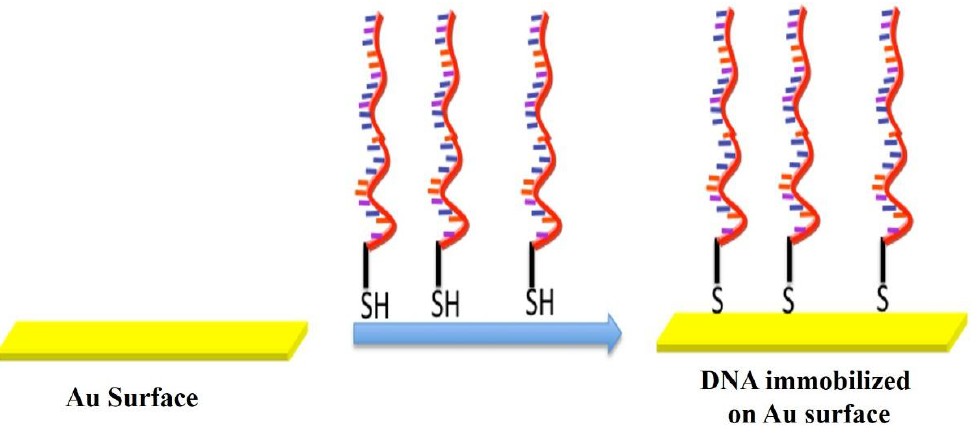
Figure 2. DNA immobilization on Au (Gold)